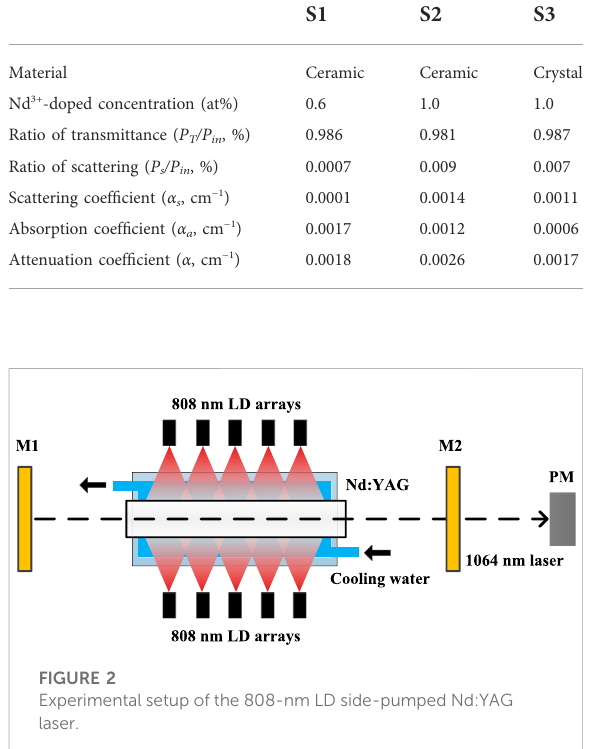
ef fi ciency. The laser experimental con fi guration is shown in Figure 2. The samples were surrounded by arrays of diode lasers with a total pump power of 180 W. The Nd:YAG rod to match the pump radiation wavelength of the LD and the 808.5 nm absorption spectrum of Nd:YAG. The mirror M1 was coated with high re fl ectance (HR) at 1,064 nm, and the mirror M2 was an output coupler with partial re fl ectivity of 80% at 1,064 nm. The 1,064 nm output power was monitored using the PM. The total cavity length is about 70 mm.